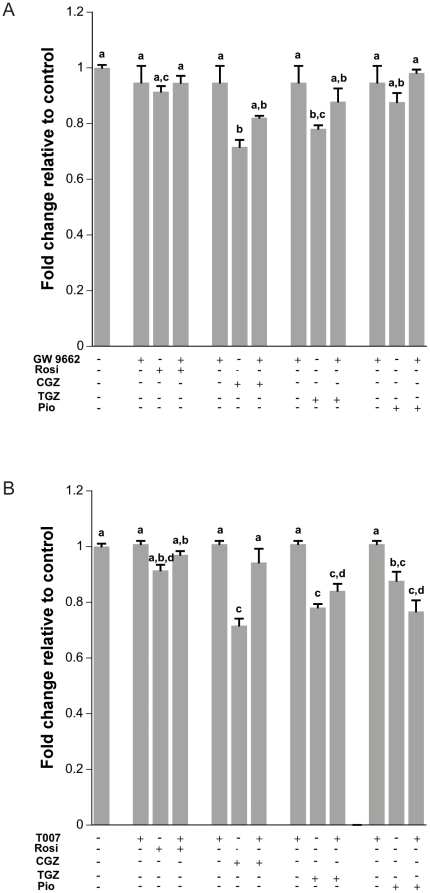
Effect of PPARγ antagonists on Ovcar3 proliferation.Cells were treated with GW9662 (A) or T007 (B) for 24 h and cell proliferation was assessed. Results are the means ± SEM for at least 4 measurements. Bars that do not share a letter designation are significantly different (p<0.05).